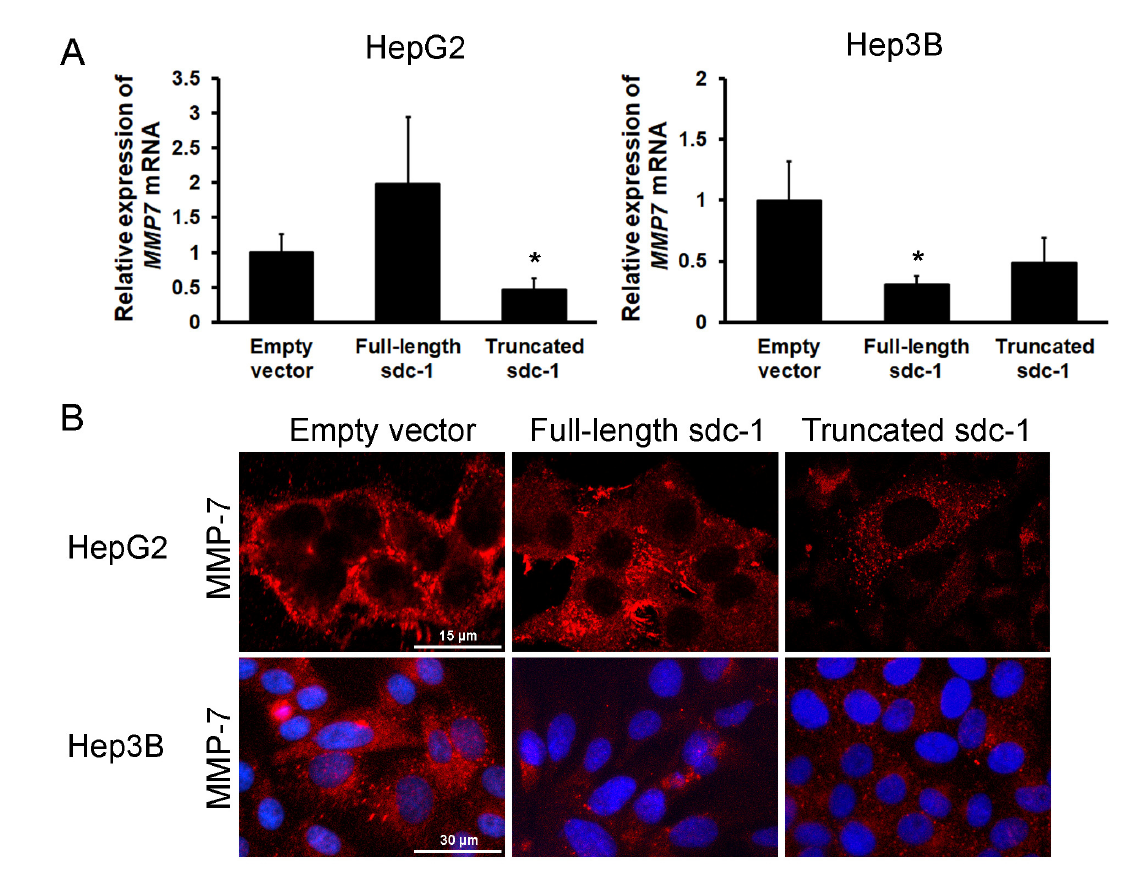
Figure 6. The effect of syndecan-1 constructs on MMP-7 expression. ( A ) Except for HepG2 transfected with full-length syndecan-1, all other syndecan-1 transfectants displayed decreased MMP7 mRNA expression and ( B ) protein levels as compared with the empty vector transfected cells. Red, MMP-7 and blue, nuclei. Data points represent the mean ± SD, n = 3; * p < 0.05 versus the empty vector transfectant. Representative images are at 1000 × magnification (scale bar 15 µ m) and 600 × magnification (scale bar 30 μ m).